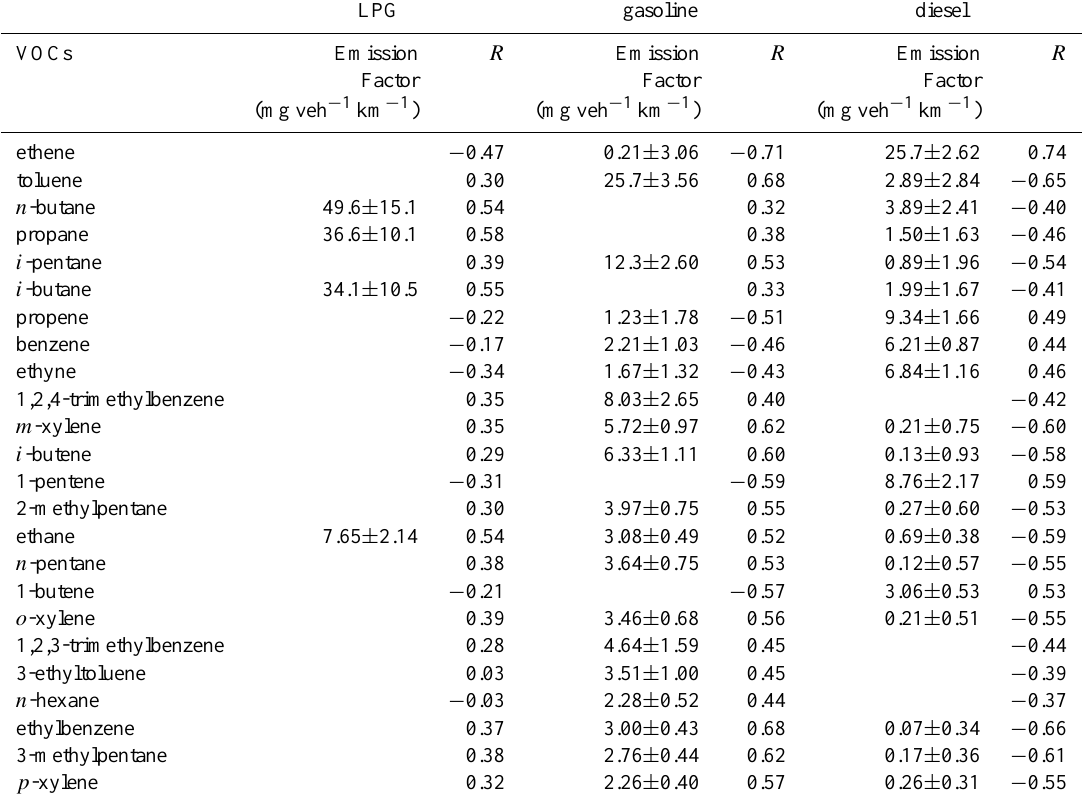
Table 4. Emission factors of select VOC compounds for LPG, gasoline and diesel-fueled vehicles from regression of experimental data. LPG gasoline diesel VOCs Emission R Emission Emission Factor